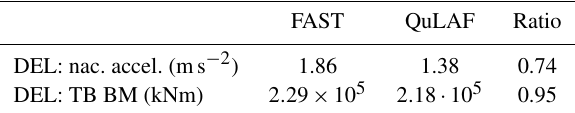
Table 4. FAST and QuLAF probability-weighted DEL results, based on probabilities from the Weibull distribution of NSS (Krieger et al.,